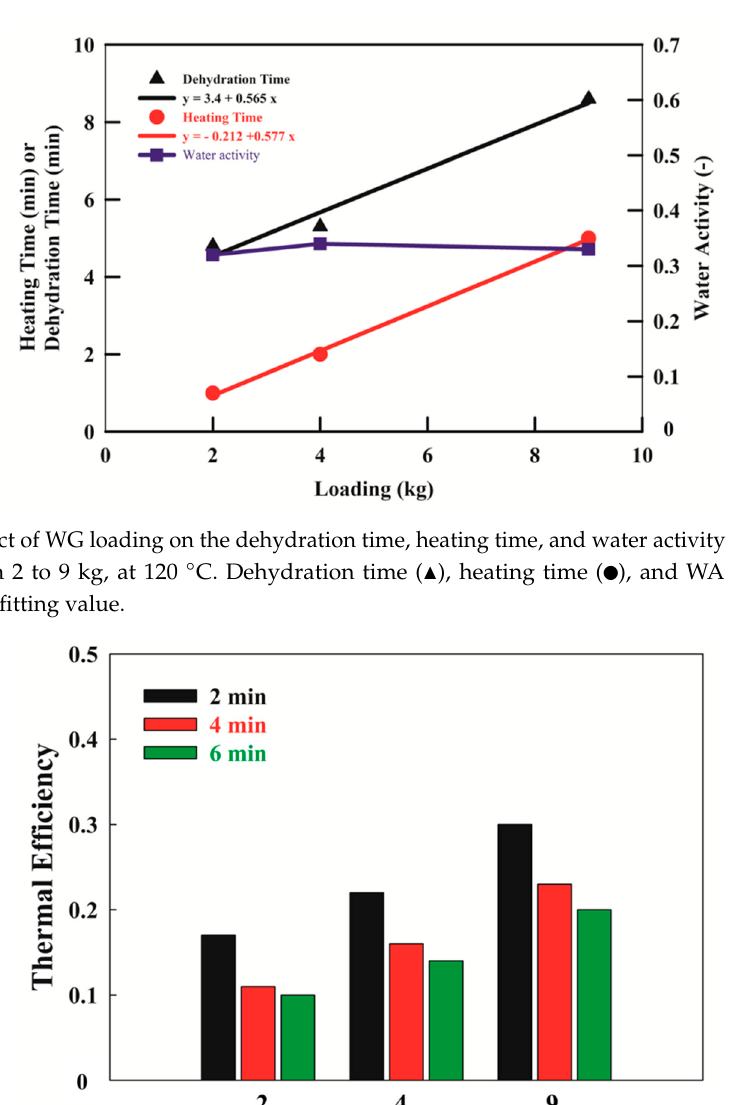
● ), and WA ( ▓ ); the lines